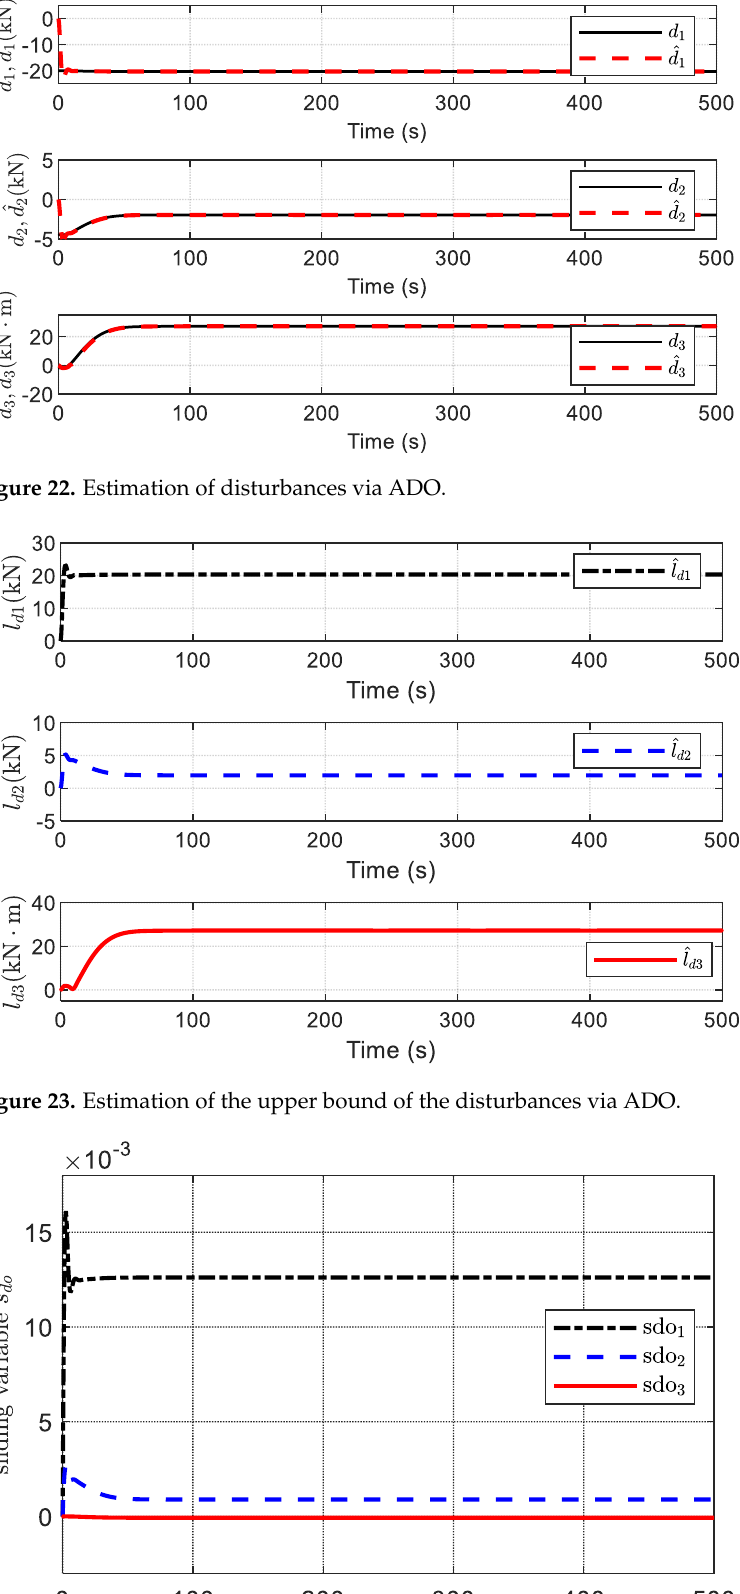
Figure 25. The TSM surface of the controller.